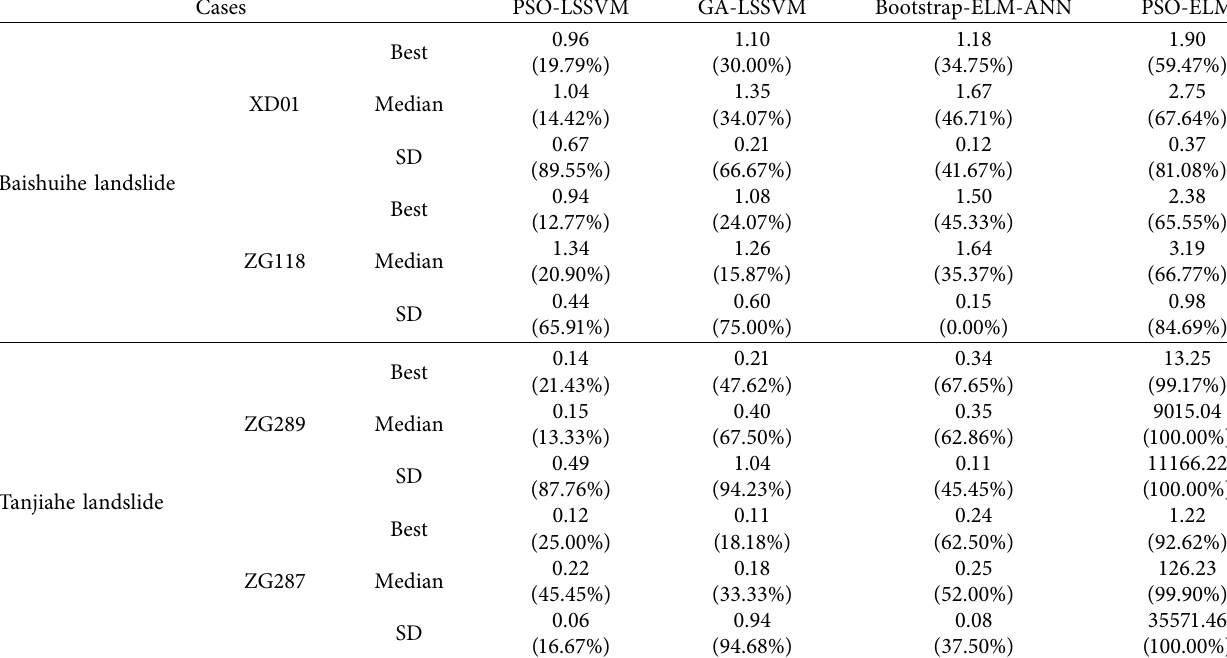
Table 3: CWC comparisons between the proposed and compared methods.